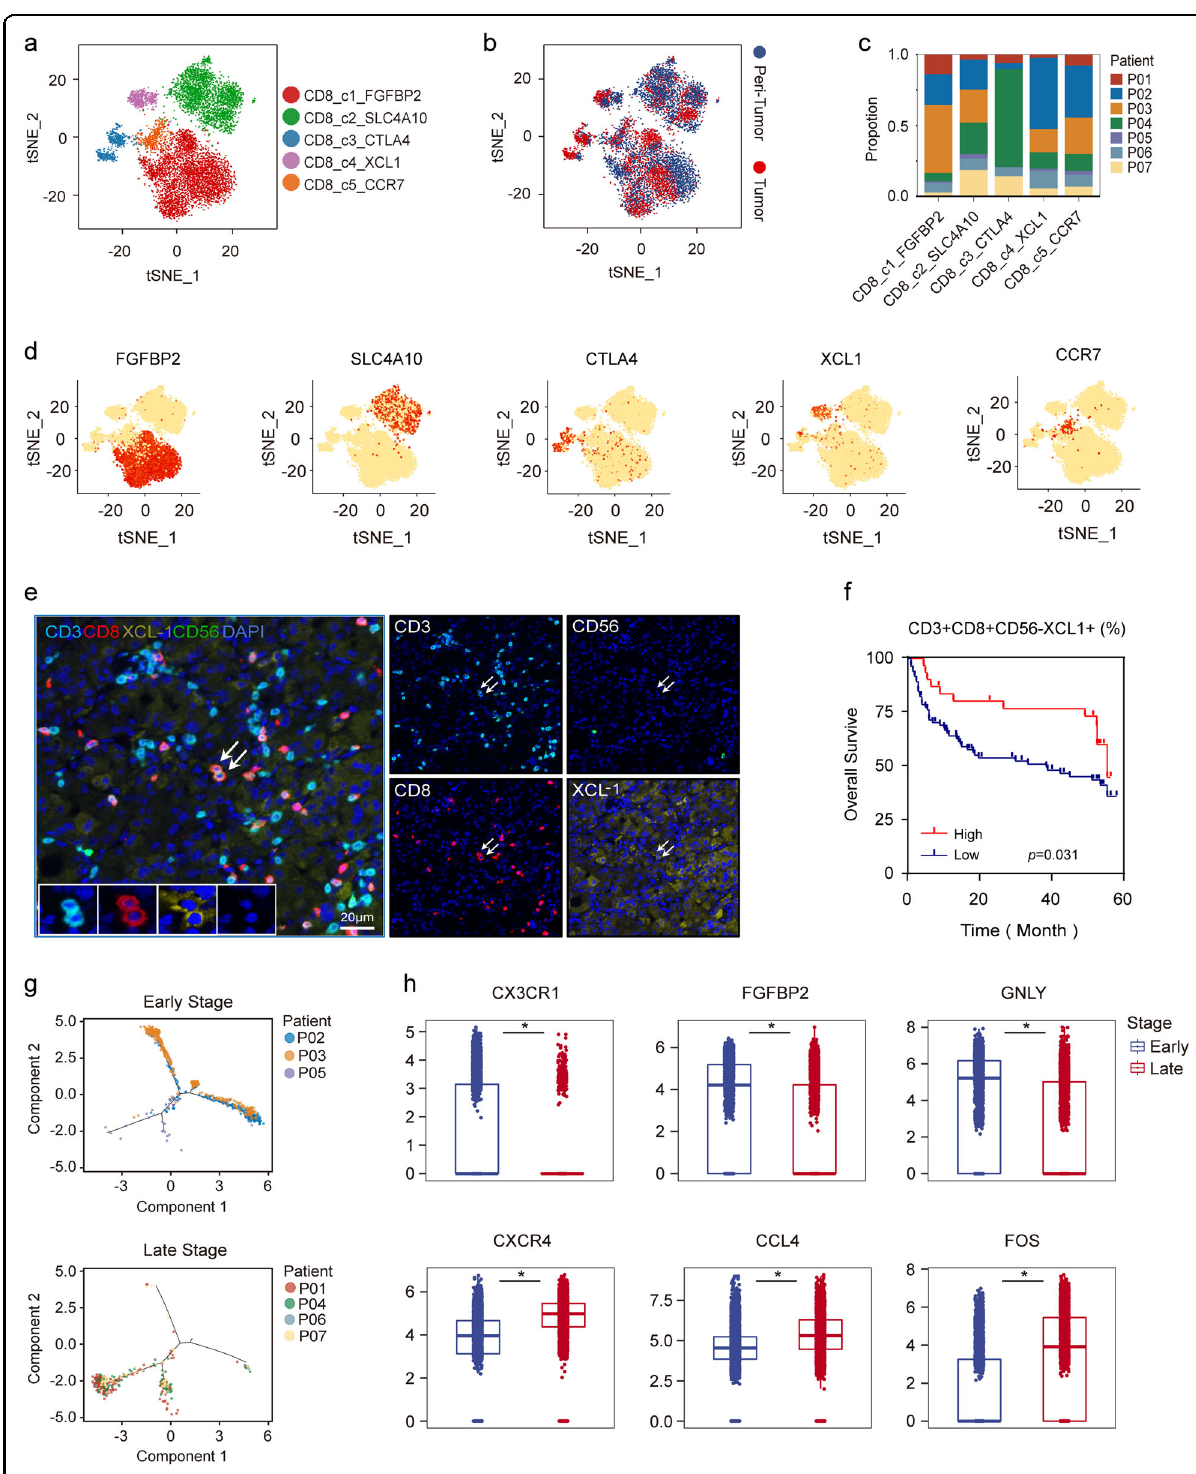
Fig. 5 In fi ltration of diverse CD8 + T-cell subsets in HCC. a t-SNE projection of all CD8 + T cells showed in different colors. b t-SNE plots of